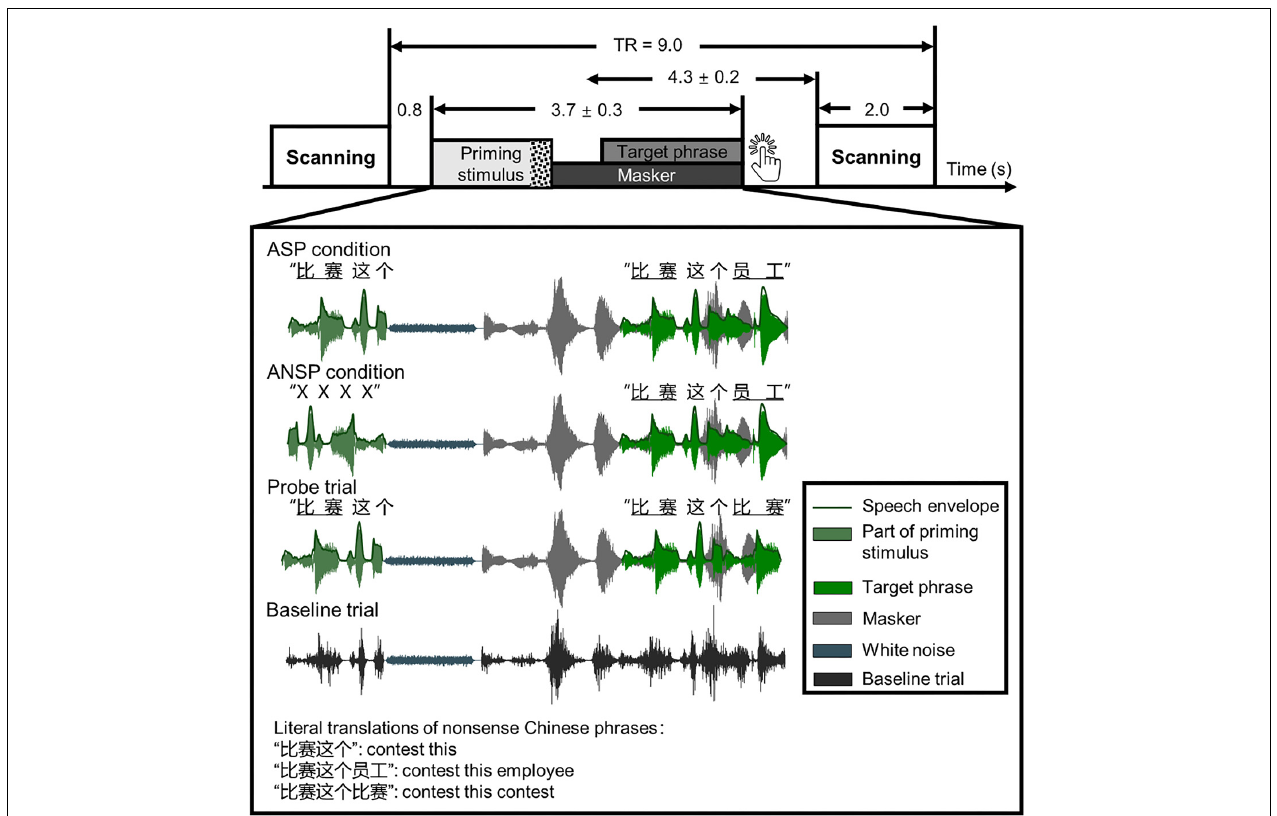
FIGURE 1 | Schematic of a single trial presenting sound stimuli in a functional run. Sparse temporal sampling was used. Four kinds of sound structures of the functional runs are illustrated separately. The temporal midpoint of the sound stimulus was 4,300 ms prior to the onset of scanning for a given trial. The unit of time in this figure is second(s). TR, time to